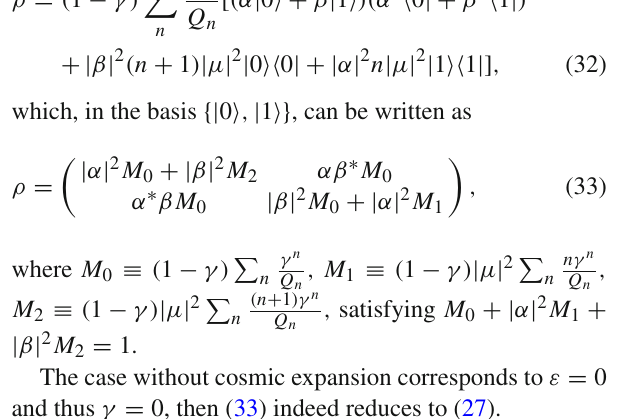
the qubit remains as the initial. In other words, in order to